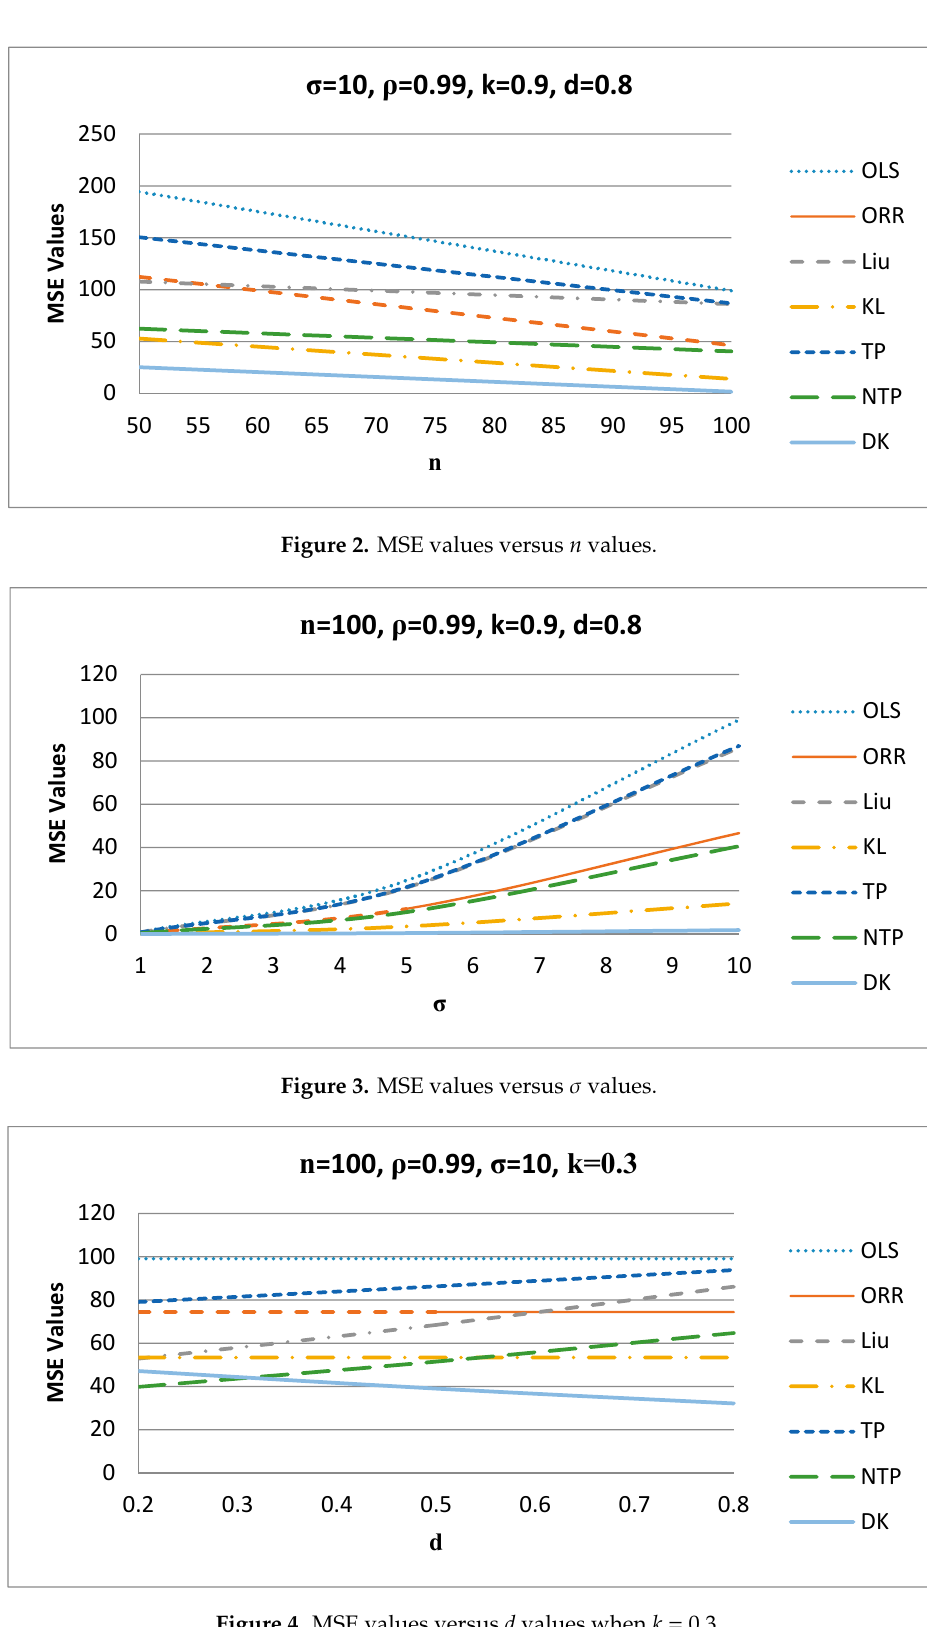
Figure 1. MSE values versus